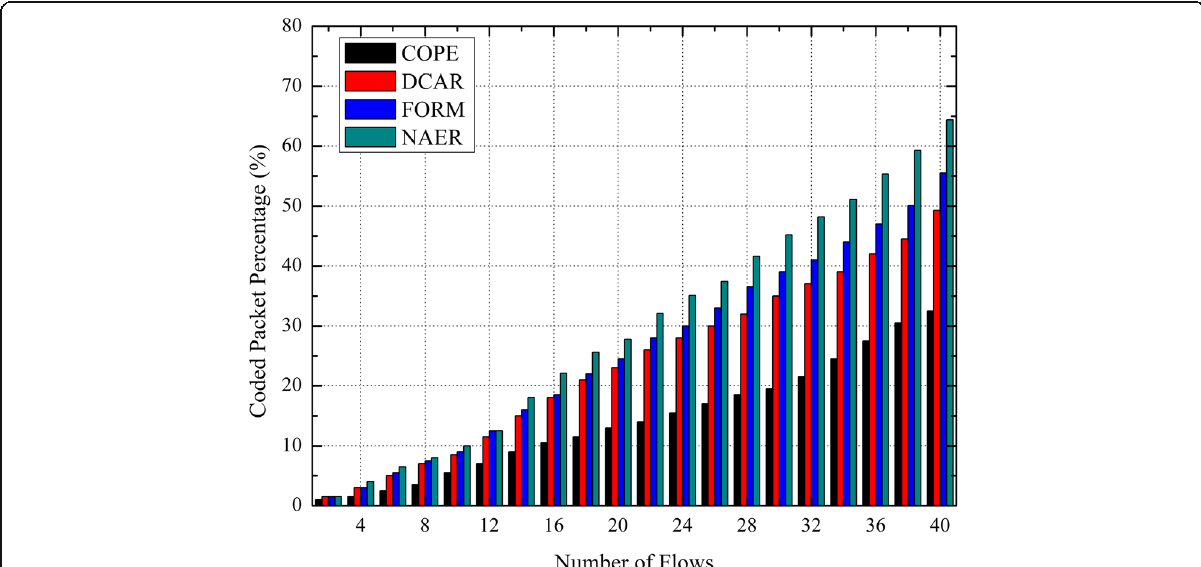
Fig. 23 Coded packet percentage under different number of flows in grid network. Figure 23 shows the coded packet percentage comparison of COPE, DCAR, FORM, and NAER under different number of flows in grid